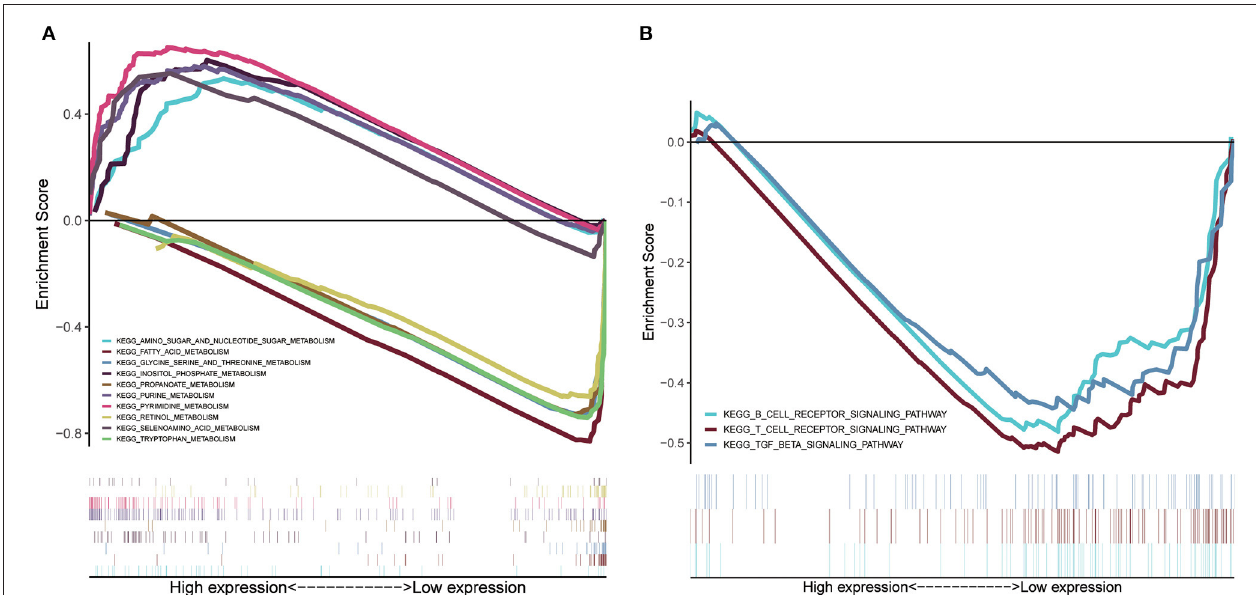
FIGURE 7 | GSEA of risk score-related signaling pathways. (A) The top five enriched metabolism-related pathways in the high- and low-risk group. (B) Signaling pathways related to tumor immunity of the low-risk group.